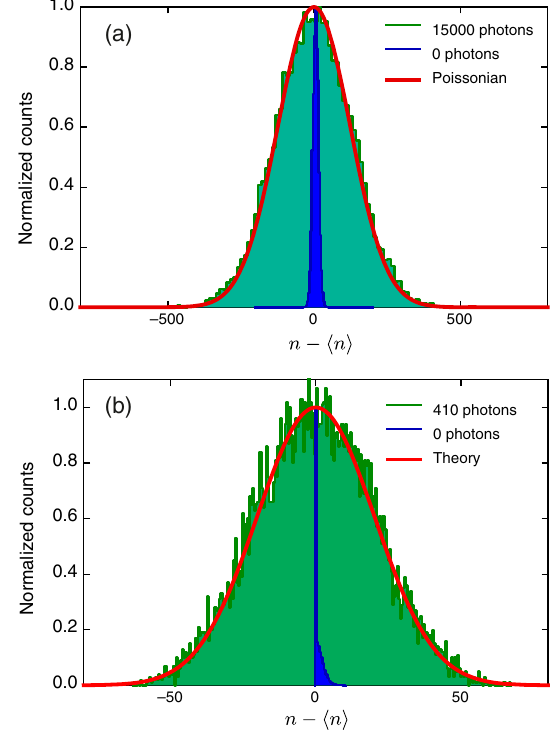
FIG. 6. Measurement of the quantum and classical noise of our ATIK (a) and Nokia (b) detectors. At the operating conditions, quantum noise strongly